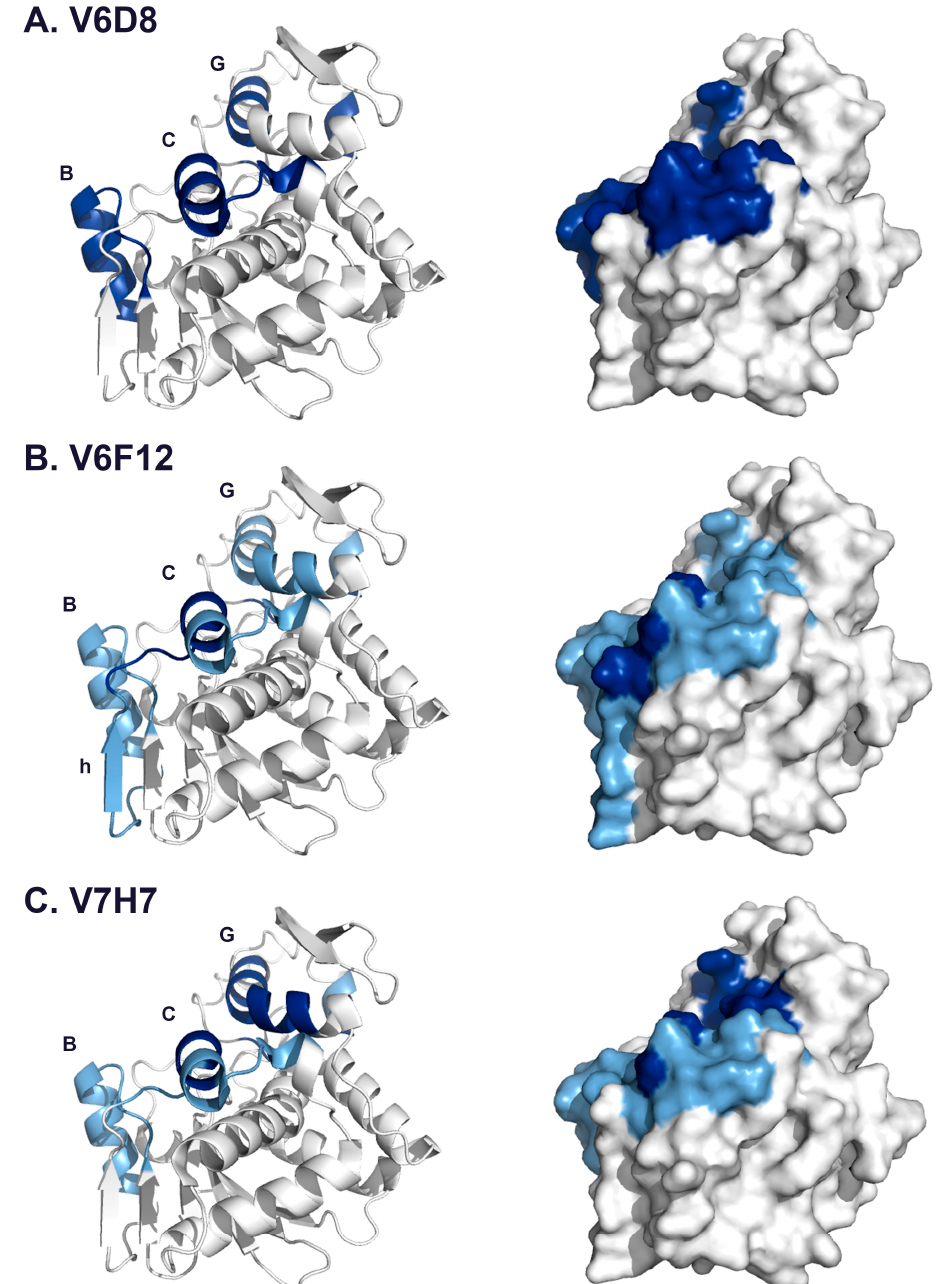
Figure 7. Epitope locations of V6D8, V6F12 and V7H7 on RiVax. HX protection categories shown in Figure 6 were mapped onto the structure of RiVax for ( A ) V6D8 ( B ) V6F12 and ( C ) V7H7. Secondary structure elements including α -helices B, C and G and β -strand h are labeled. Intermediate protection by V6D8 is spread over much of RiVax’s surface and the magnitudes of protection are low. Therefore, only strongly protected elements are mapped onto the crystal structure of RiVax. The color shading corresponds to strong (deep blue) or no significant protection (gray).